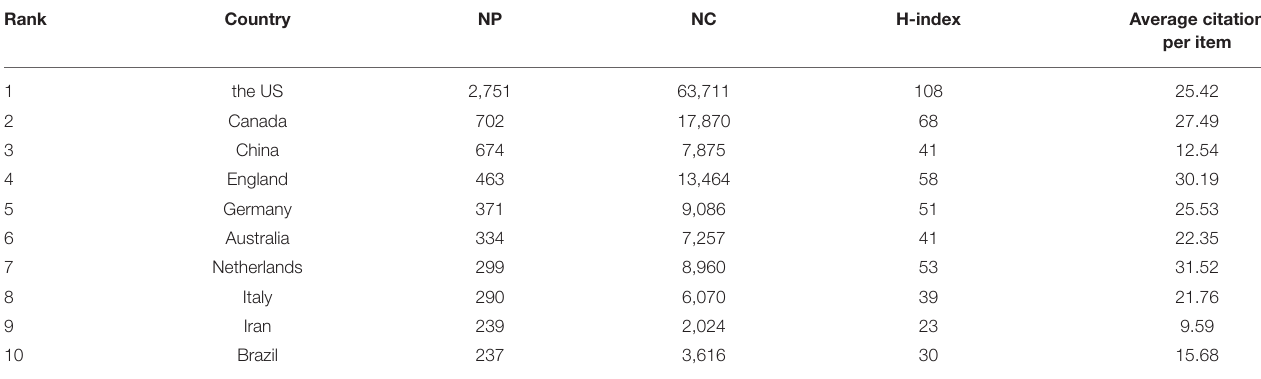
TABLE 1 | Top 10 productive